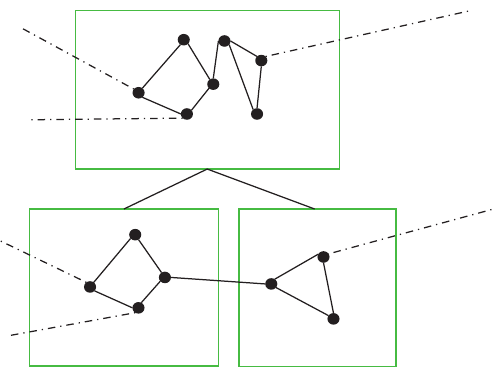
Figure 11: A neighbor for modularization Figure